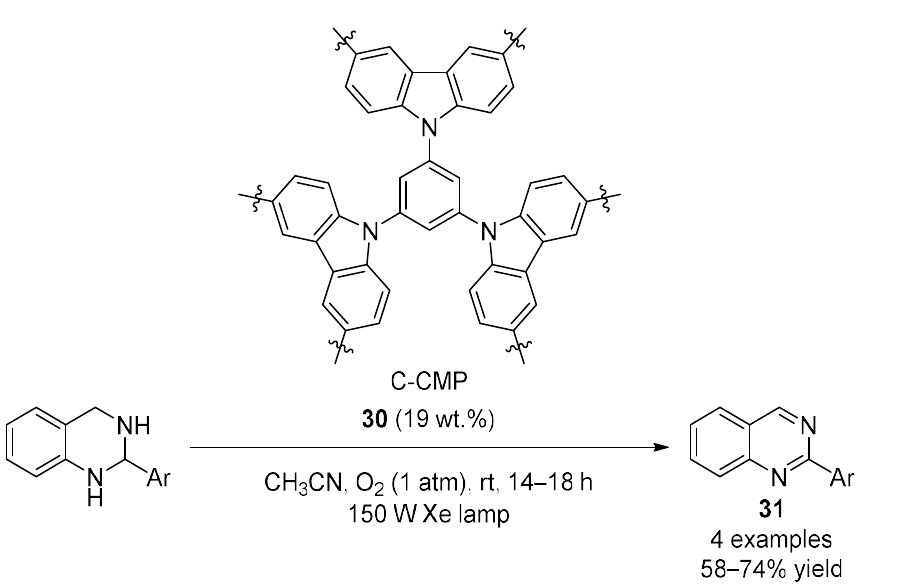
Scheme 14. Aerobic photo-oxidation of tetrahydroquinazolines to quinazolines 31 catalyzed by 30 .